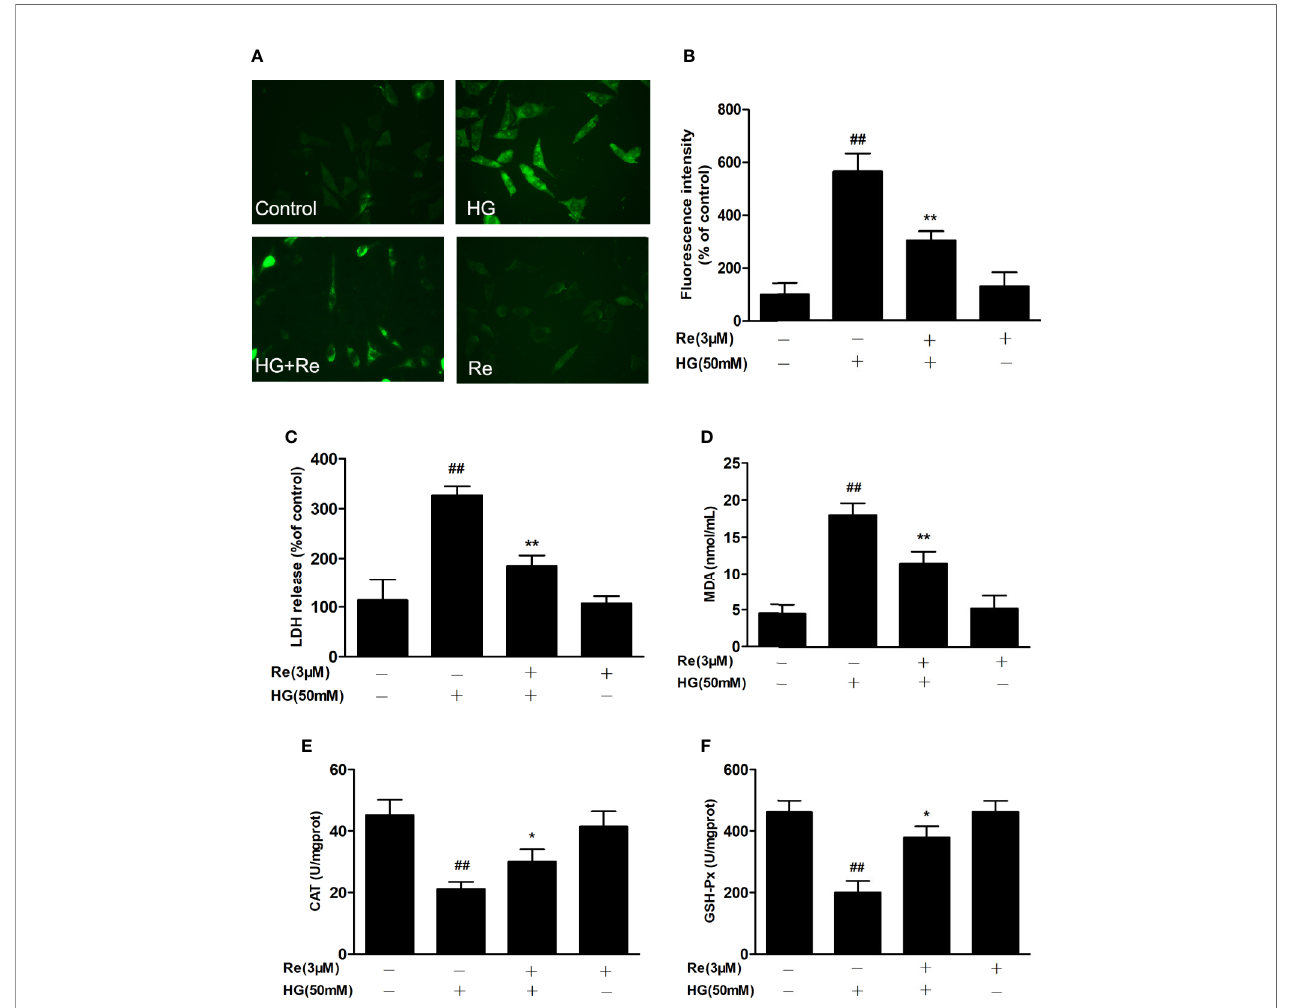
FIGURE 3 | Ginsenoside Re attenuated HG-induced RF/6A cell injury and oxidative stress. (A) ROS levels were monitored using a fl uorescence microscope. (B) Statistical analysis of ROS fl uorescence intensity. The enzymatic activities of LDH (C) , MDA (D) , CAT (E) , and GSH-Px (F) were detected by spectrophotometry. The data are presented as the mean ± standard error of the mean (n = 5). ## P < 0.01 versus the control group; *P < 0.05, **P < 0.01 versus the HG group. Scale bar, 50 m